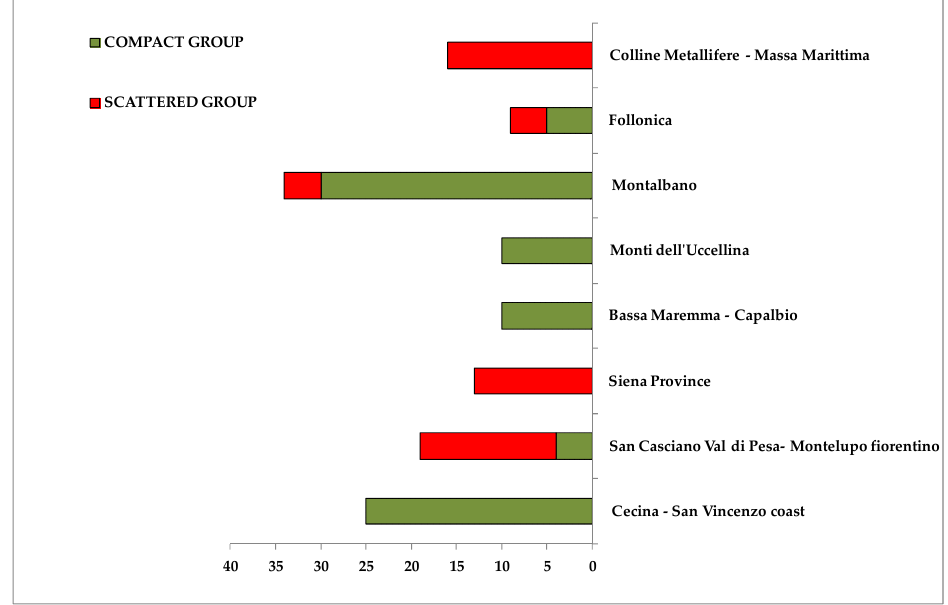
Figure 4. Bars chart representing percentage distribution of samples from each main geographical origin areas into two identified macro groups. Green and red rectangles indicate percentage contribution to the compact and scattered macro-groups respectively. X axis reported the number of samples.